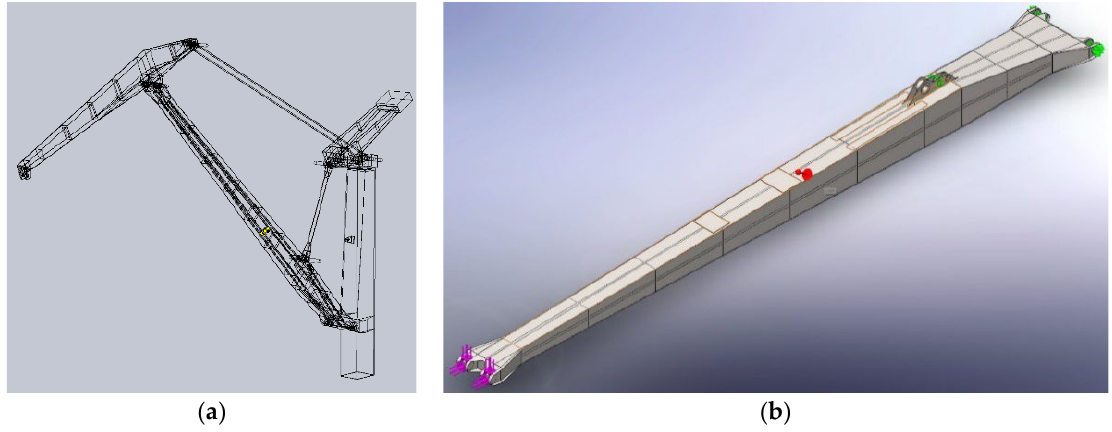
Figure 1. ( a ) KANGUR crane assembly, ( b ) main arm, 1:1 scale